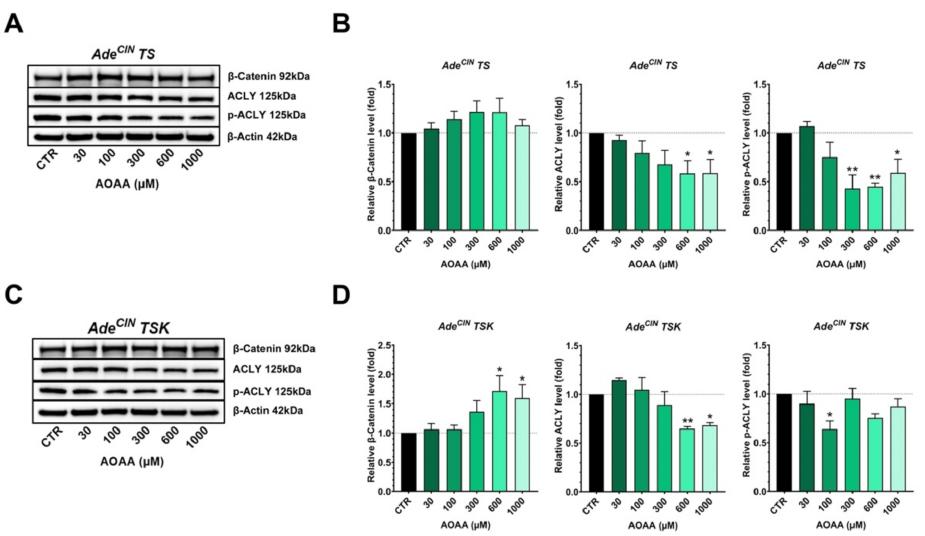
Figure 9. Effect of pharmacological inhibition of CBS/CSE on the induction of the Wnt/ β -catenin pathway in Ade CIN TS and Ade CIN TSK organoids . ( A , B ) Western blot analysis of β -catenin, ACLY and p-ACLY in Ade CIN TS in the presence of increasing concentrations of AOAA for 48 h. ( C , D ) Western blot analysis of β -Catenin, ACLY, and p-ACLY in Ade CIN TSK in the presence of increasing concentrations of AOAA for 48 h. Data represent mean ± SEM of at least 4 independent experiments. * p < 0.05, ** p < 0.01 compared to